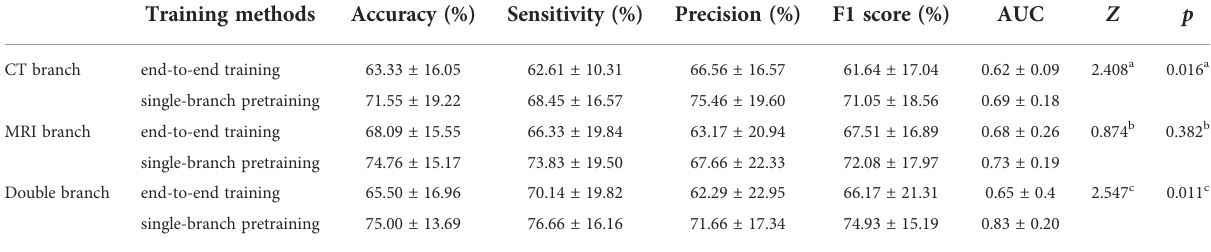
TABLE 3 Comparison between end-to-end training and single-branch pretraining on the performance of the fi nal model.